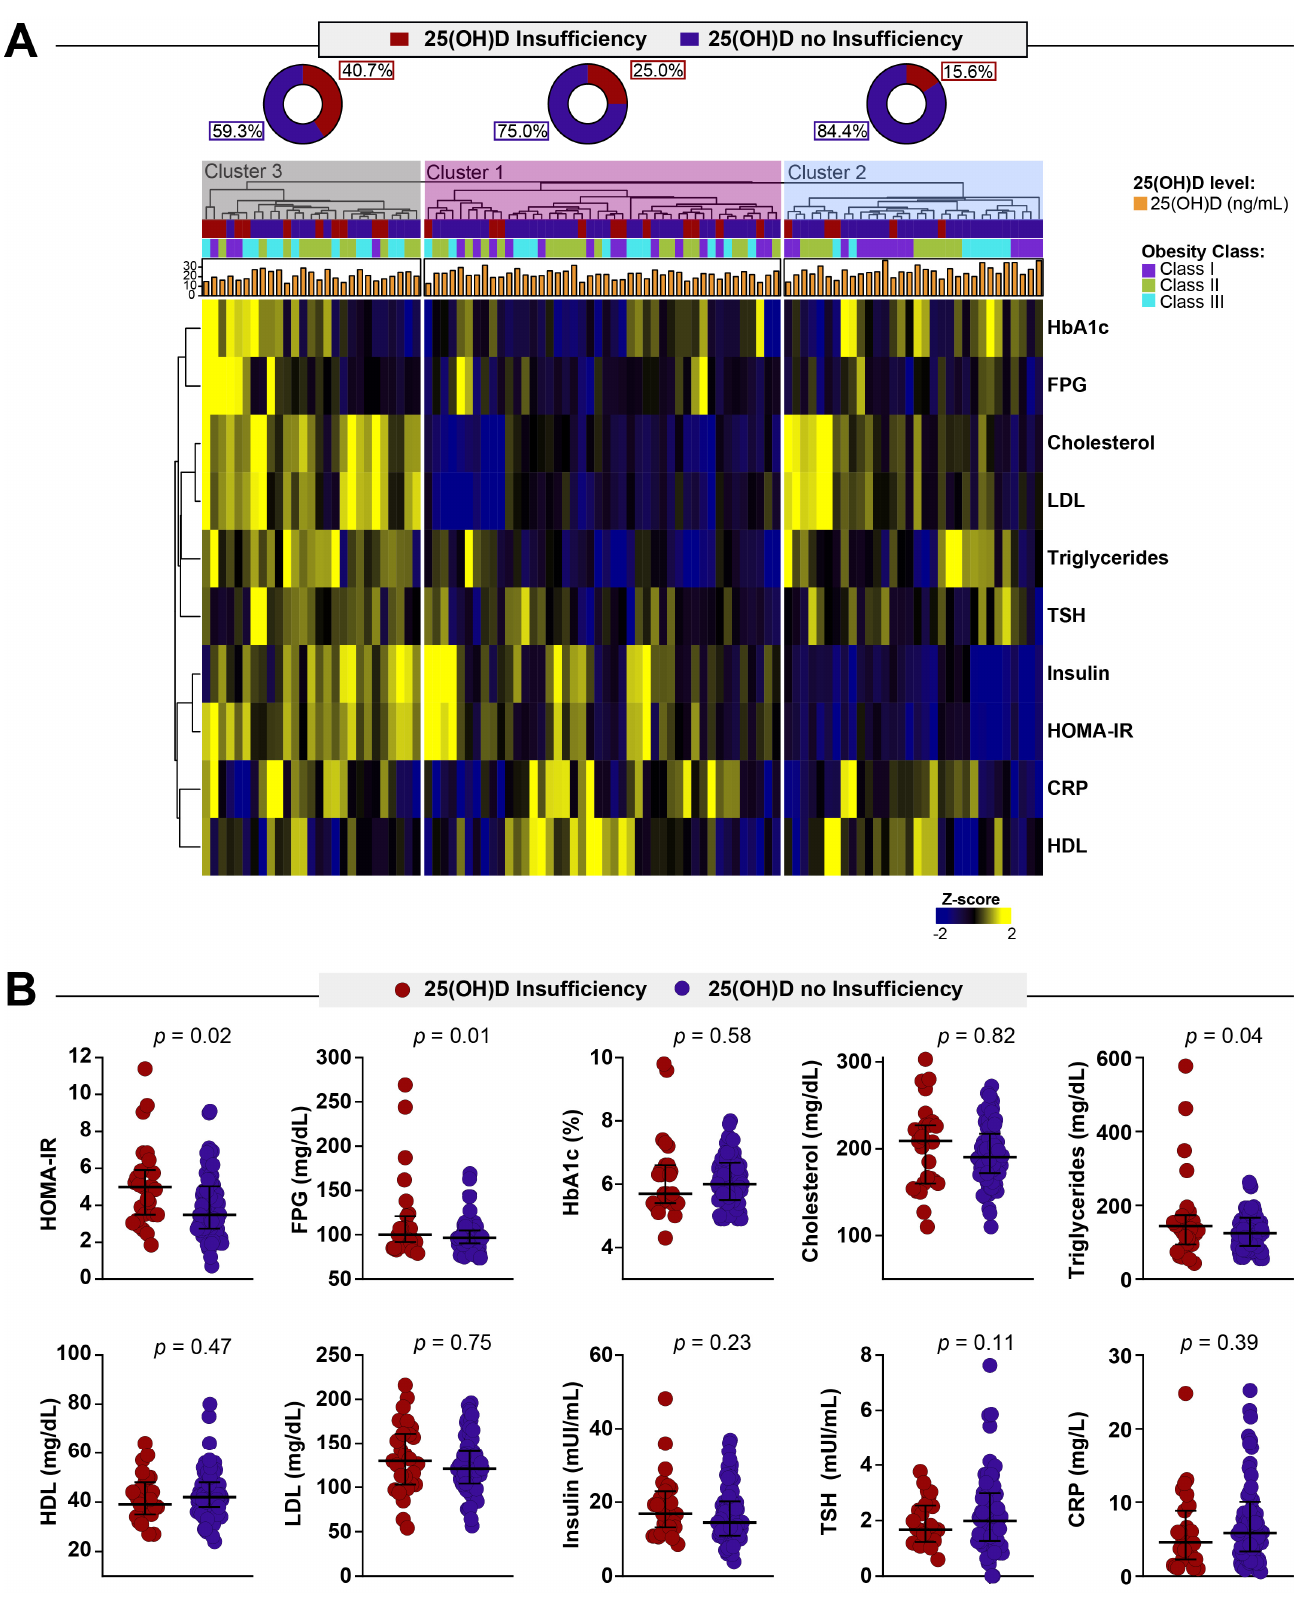
Figure 2. Biochemical profiles of obese women stratified by 25-hydroxyvitamin D status. ( A ) Value of each parameter was log10 transformed. Mean values for each indicated clinical group were z ‐ score normalized, and a hierarchical cluster analysis (Ward’s method with 100xbootstrap) was performed to illustrate the overall biochemical profiles. ( B ) Data represent median and interquartile ranges. The Mann–Whitney U test was employed to compare the values detected between the